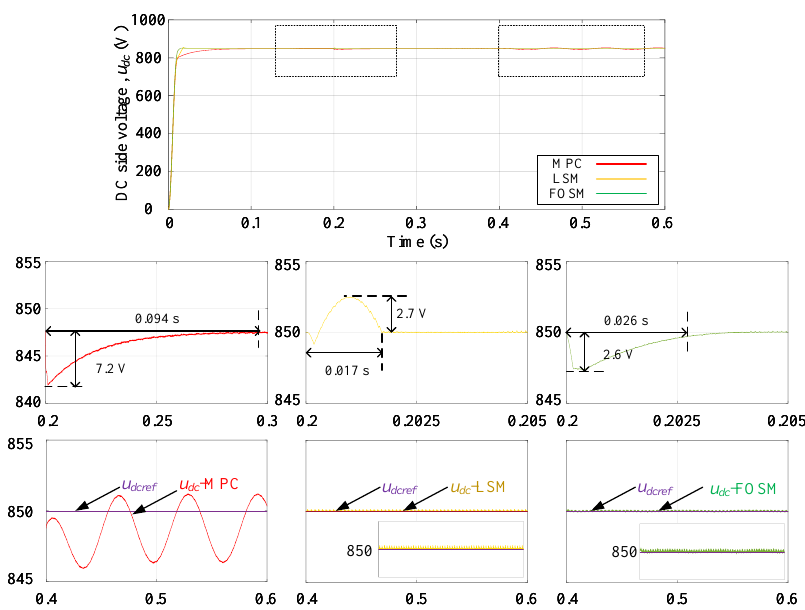
To attest the excellent dynamic performance and robustness of the proposed control method, the load grid current i 2 d is changed from 40 A to 80 A at 0.2 s, and the external disturbance ρ 1 ( t ) = 5 sin ( 100 t ) and ρ 2 ( t ) = diag ( 100 sin ( 100 t ) , 100 sin ( 100 t )) are added at 0.4 s. The parameters of the resistances, inductances and capacitance are set to the original value. The simulation starts at 0 s and runs for 0.6 s in total. From Figure 9, the setting time of the DC-side voltage response under the MPC, the LSM and the FOSM are 0.094 s, 0.0017 s and 0.0026 s, respectively. Moreover, the DC-side voltage drop under the three control methods are 7.2 V, 2.7 V and 2.6 V, which means that the proposed FOSM controller has a better dynamic performance in anti-disturbance and rapidness. After the external disturbance ρ 1 ( t ) is added at 0.4 s, it is obvious that the outer-loop PI controller cannot suffer the external disturbance in the form of sinusoid. The FOSM controller can deal with the added external disturbance ρ 1 ( t ) and force the DC-side voltage-tracking error to converge to zero owing to the integral-type virtual control law. The LSM controller can also eliminate the external disturbance; however, the irreducible chattering exists in the control signal as shown in Figure 10. Figures 11 and 12 show the load grid active and reactive power response under the three control methods. It can be seen that the MPC controller fails to deal with the sinusoidal disturbance ρ 2 ( t ) , which results in the tracking error after the external disturbance is added at 0.4 s. The LSM and FOTSM controllers compensate for the external disturbance completely and force the tracking error to converge to zero. However, the chattering still exists in the control law of the LSM and leads to a larger rippler than the FOTSM in the active and reactive power responses as shown in Figures 10 and 11.